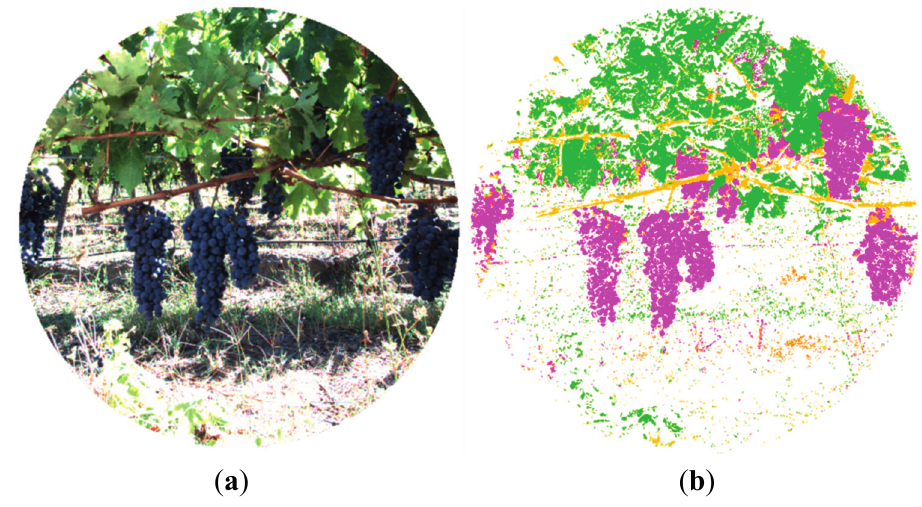
Figure 8. Vineyard. ( a ) RGB image; ( b ) Classification map.